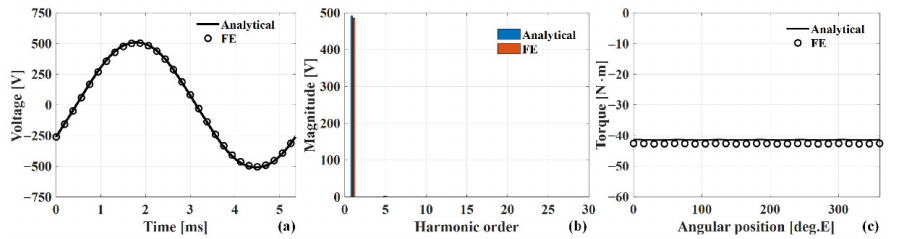
Figure 6. Electromagnetic performance: ( a ) induced-voltage waveform; ( b ) FFT result for the induced voltage; ( c ) rated torque.